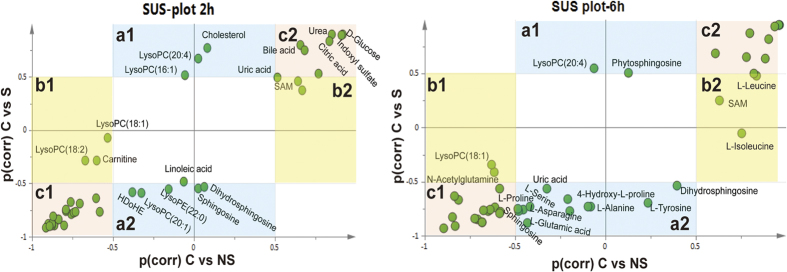
SUS plot of survival and non-survival rats at 2 h and 6 h, respectively.All metabolites not significant (|p(corr)| <0.5) in either model were removed in this plot to enhance visualization.